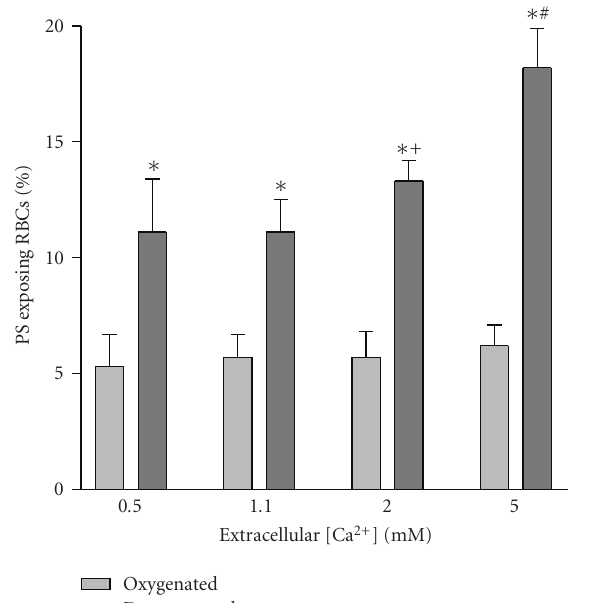
Figure 1: E ff ect of oxygen tension and extracellular Ca 2+ on phosphatidylserine (PS) exposure in red blood cells (RBCs) from sickle cell patients. RBCs were incubated for 18 hours at four extracellular [Ca 2+ ]’s (0.5, 1.1, 2.0 and 5.0 mM) after which they were labelled with FITC-annexin (as described in Section 2).